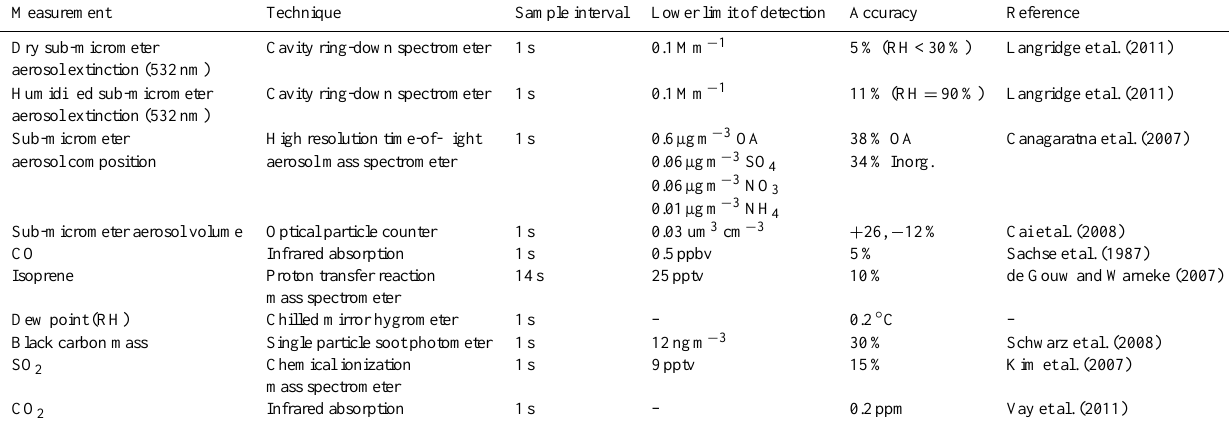
Table 2. Measurements aboard the NASA DC-8 used in this analysis. The sample interval corresponds to the rate at which data are reported and is the integration time for the lower limit of